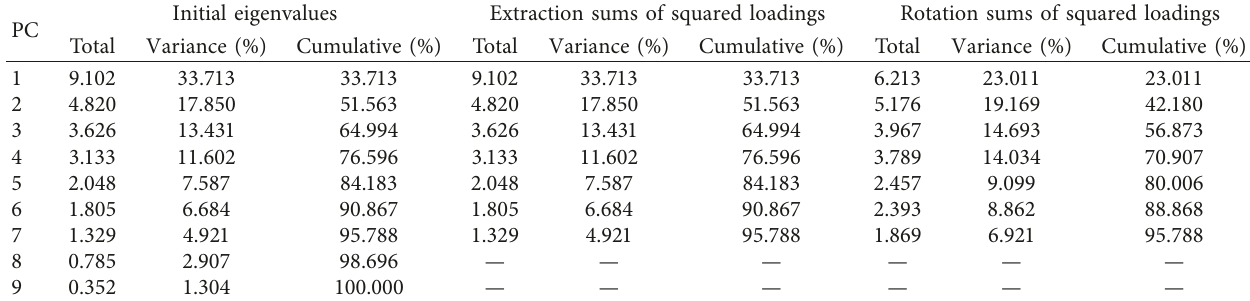
Table 4: Total variance obtained using principle component analysis (PCA).